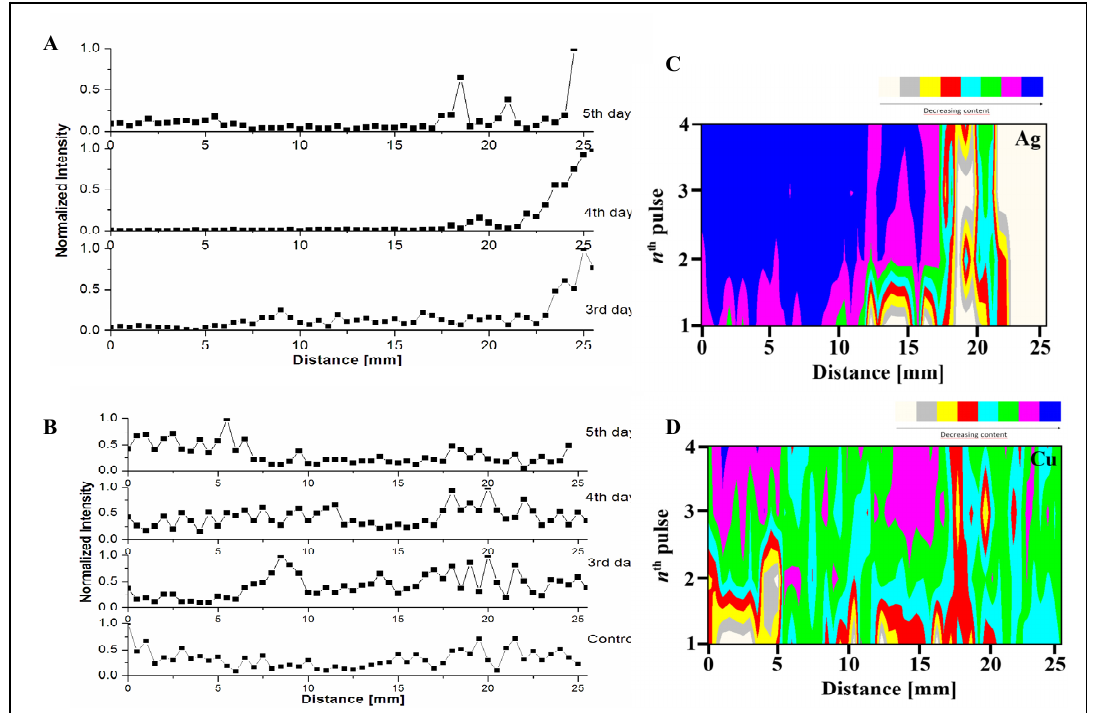
Figure 8. Accumulation of silver ( A ) and copper ( B ) along the investigated stem samples. Maps of the accumulated silver ( C ) and copper ( D ) measured by the LIBS technique for quasy 3D analyses of the stem sample of